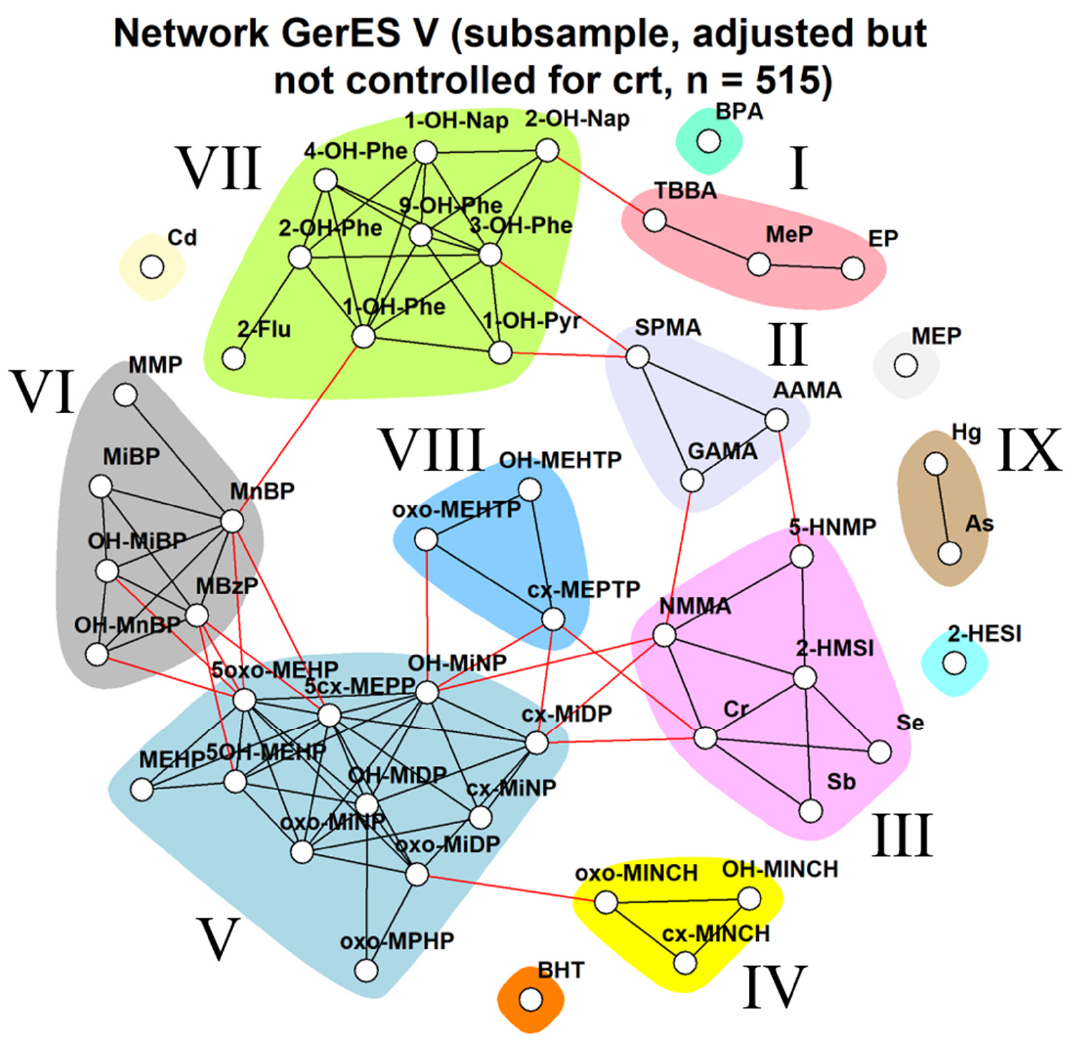
Figure A4. Network of GerES V subset, using creatinine-standardised data. Black lines indicate dependency between nodes (biomarkers) within a community; red lines indicate dependency between nodes in different communities.